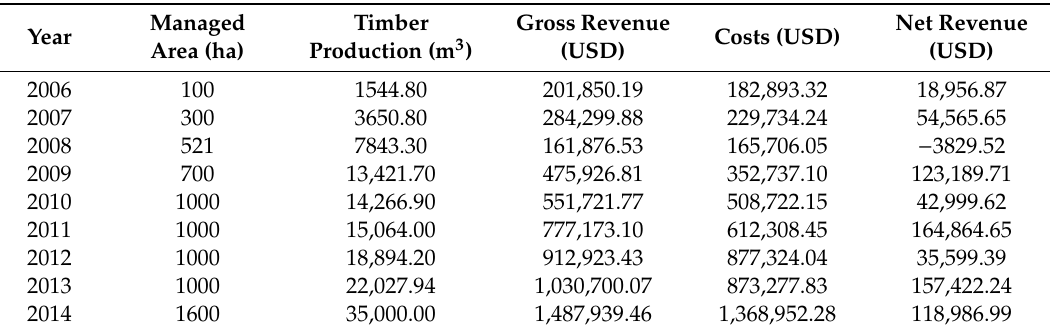
Table 2. Managed area (hectares), timber production (cubic meters), and demonstration of the results of fiscal years (real values in USD for 2015) from 2006 to 2014, of the community timber management carried out by the Mixed Cooperative of Flona do Tapaj ó s.